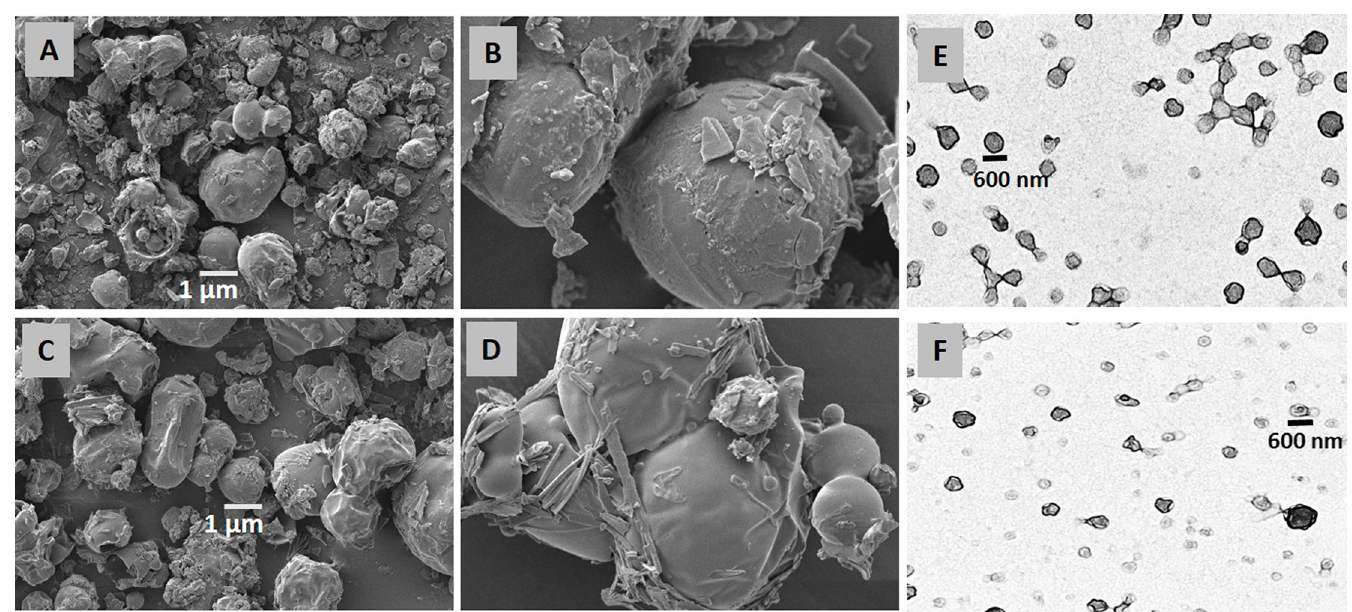
Fig 1. Scanning electron microscopic images of D5PL (A, B) and D11PL (C, D) and transmission electron microscopic images of D5PL (E) and D11PL (F).